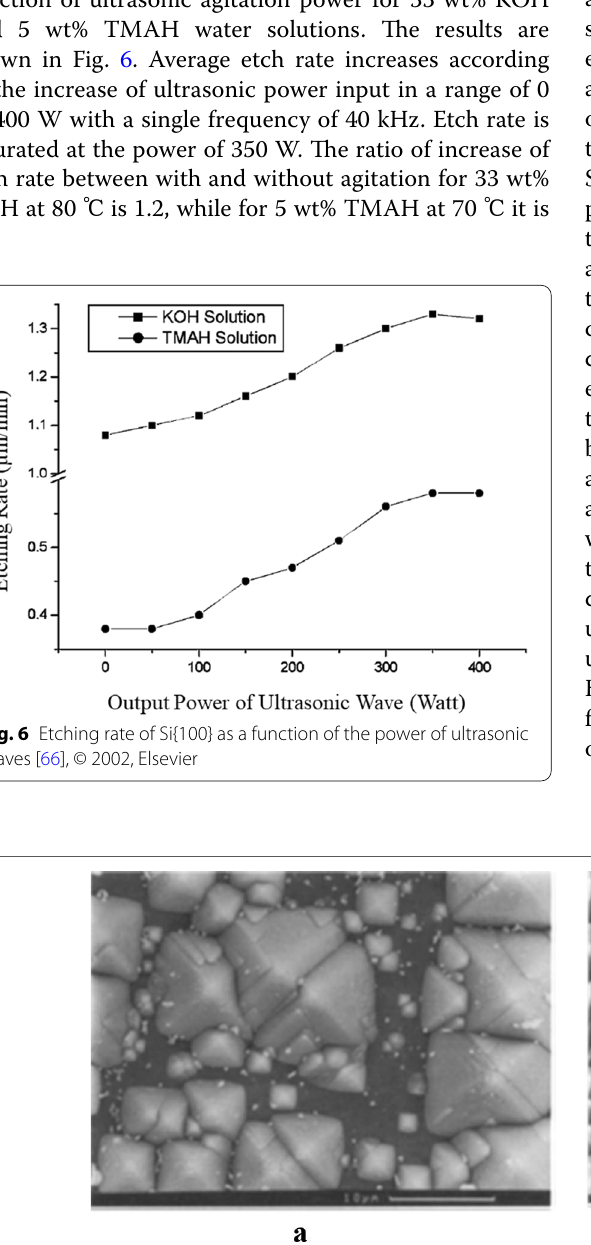
Fig. 7 SEM images of micro-pyramids on Si{100} surface after 30 min etching in 4.0 M KOH at 70 ℃ : a top view and b tilted view at 30° from {100} surface [77], © 1996 IOP